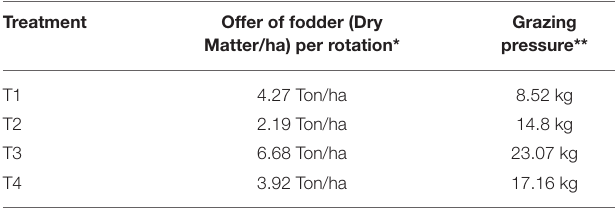
conventional system.